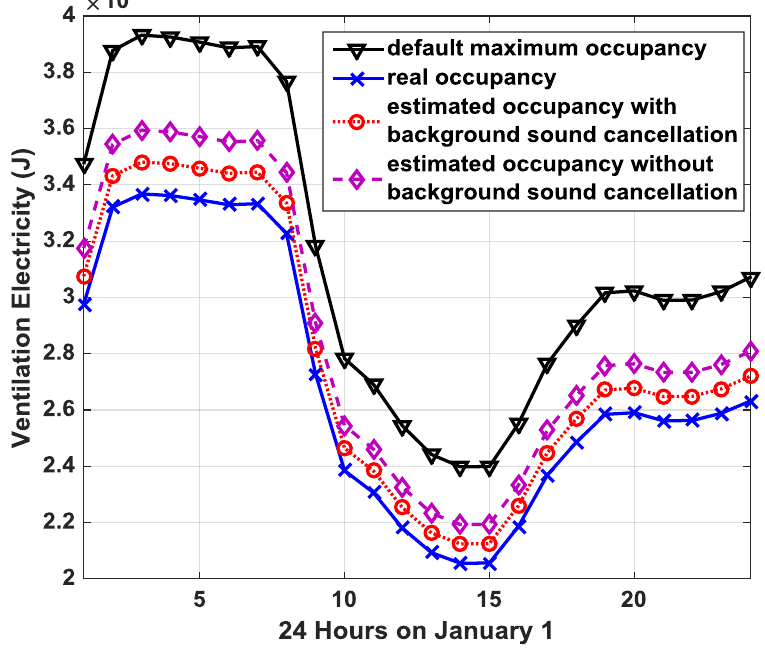
Figure 10. Simulation results of hourly ventilation electricity for 1 January.